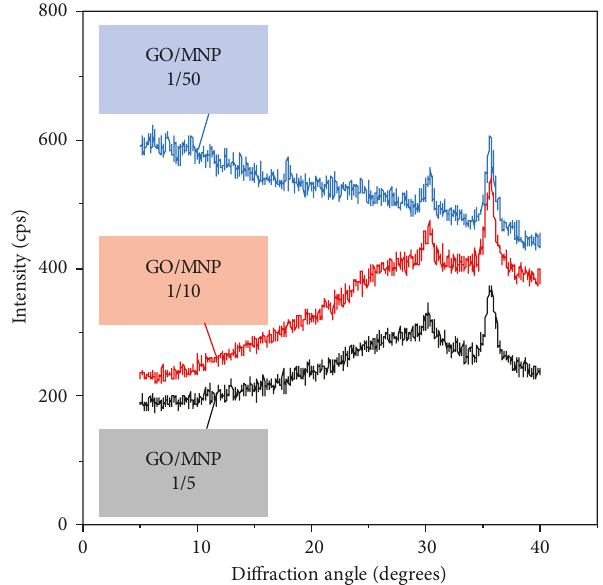
Figure 4: XRD patterns of GO/MNP nanocomposites at different mass ratios. For clarity, patterns are offset by 100